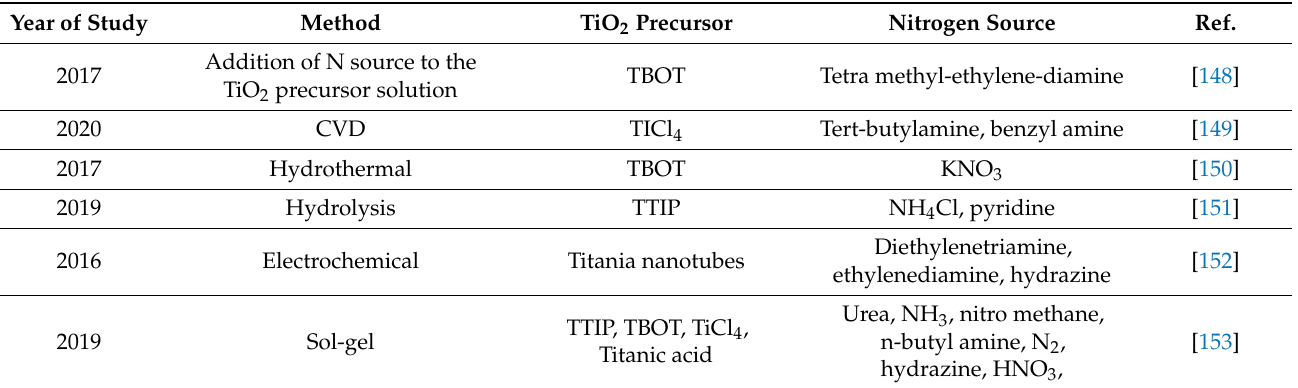
Table 5. Summary of N-doped TiO 2 photocatalysts synthesized by variety of methods and source precursor